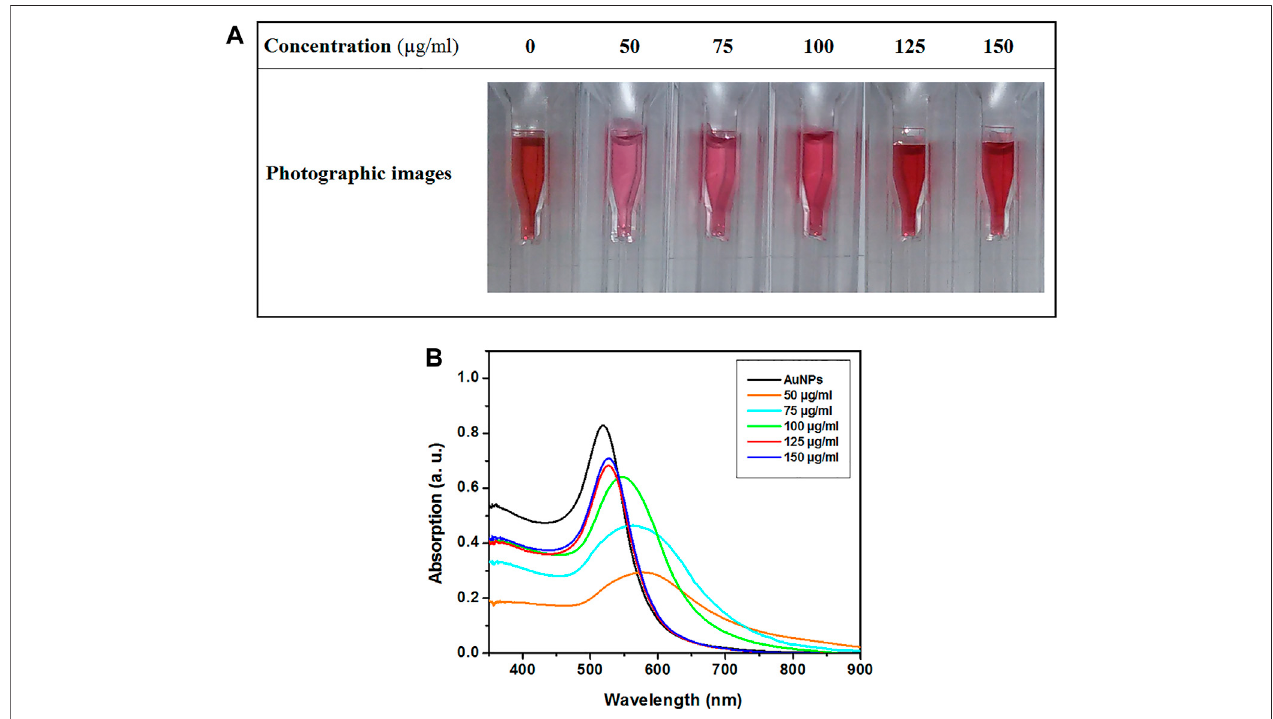
FIGURE 2 | The photographic images (A) and UV-Visible absorption spectra (B) of avidin – AuNPs after adding NaCl.